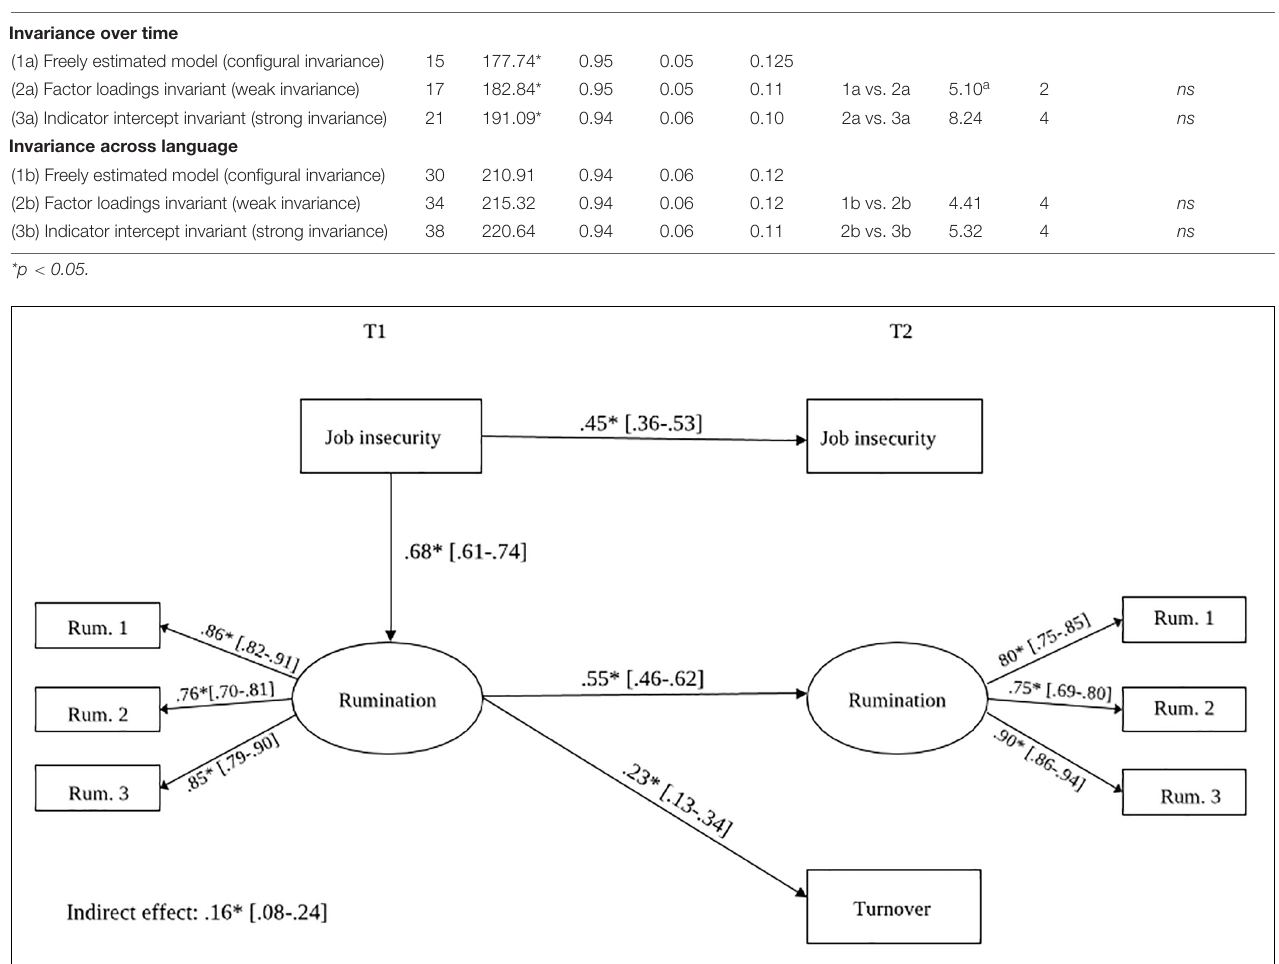
(cid:49) χ 2 (cid:49) df